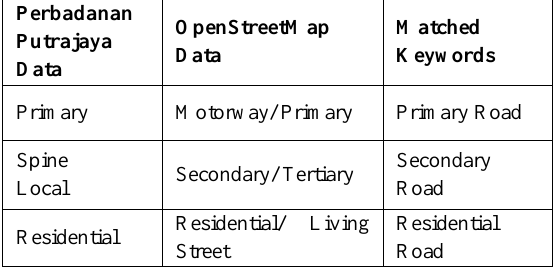
Table 1: Semantic matching between OSM and PPJ